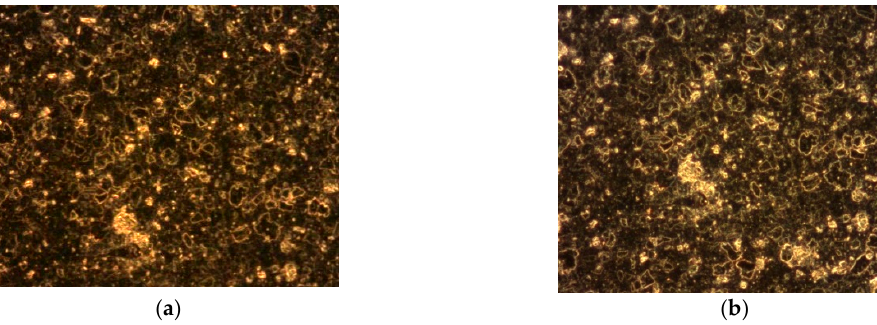
Figure 20. The images of the 1%rGO-SiO 2 -P 2 O 5 sample, deposited on glass, obtained by differential interference contrast (DIC) microscopy ( a ) before exposure to laser radiation and ( b ) after exposure to laser radiation with I inc (peak) = 7.7 GW/cm 2 .